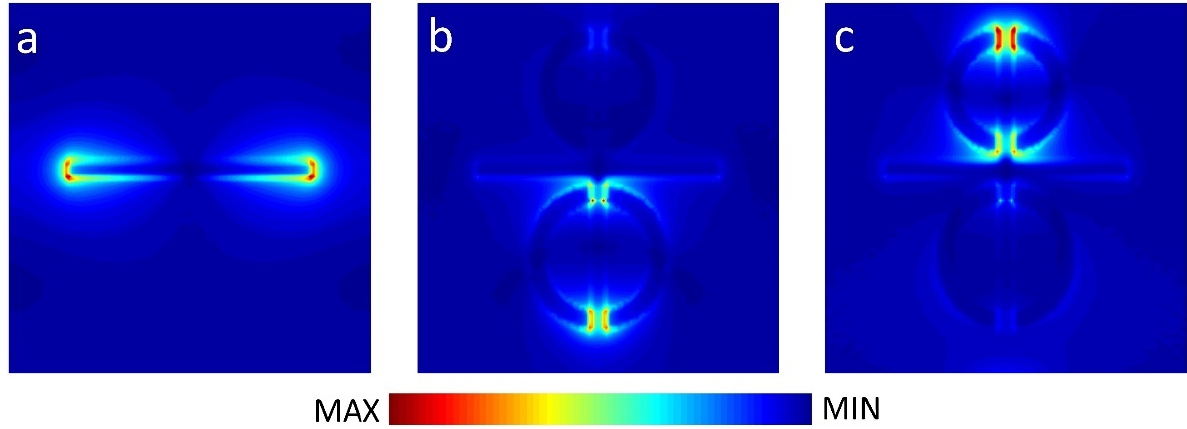
( b ) Figure 2. ( a ) The transmission spectra of isolated CW array, BDSSRs array and UDSSRs array. ( b ) The transmission spectra of the PIT metamaterial composed of two parts of DSSRs and CW. In order to analyze the mechanism of PIT effect, we studied the electric field and charge distribution at resonance frequency. As shown in Figures 3a and 4a, when CW is coupled with a plane wave, it can be observed that there is a strong electric field at the x - axis edges and corners of CW, and the charges are concentrated in the same position. This